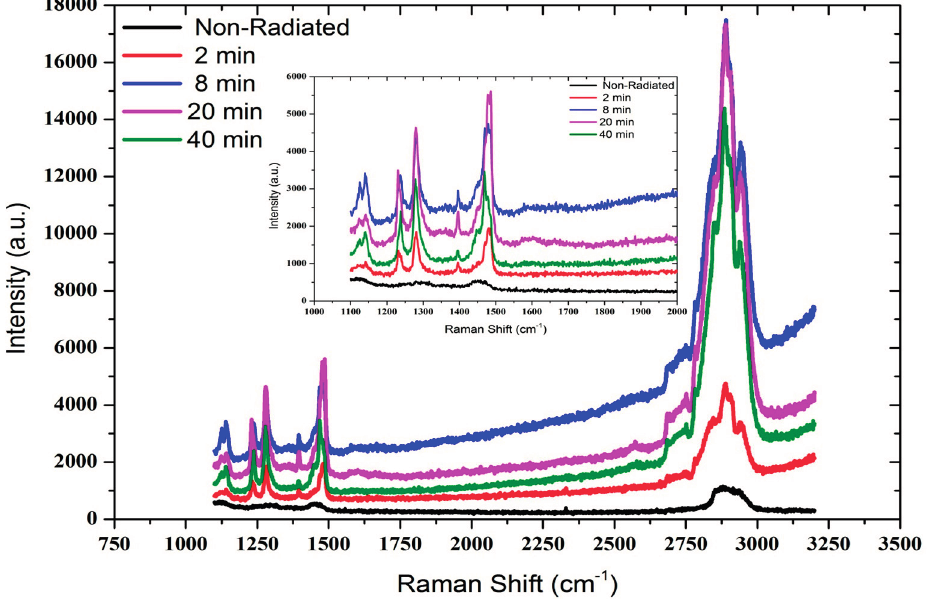
Figure 9. Raman spectra of Al/DNA/p-Si/Al junctions with and without alpha exposure.